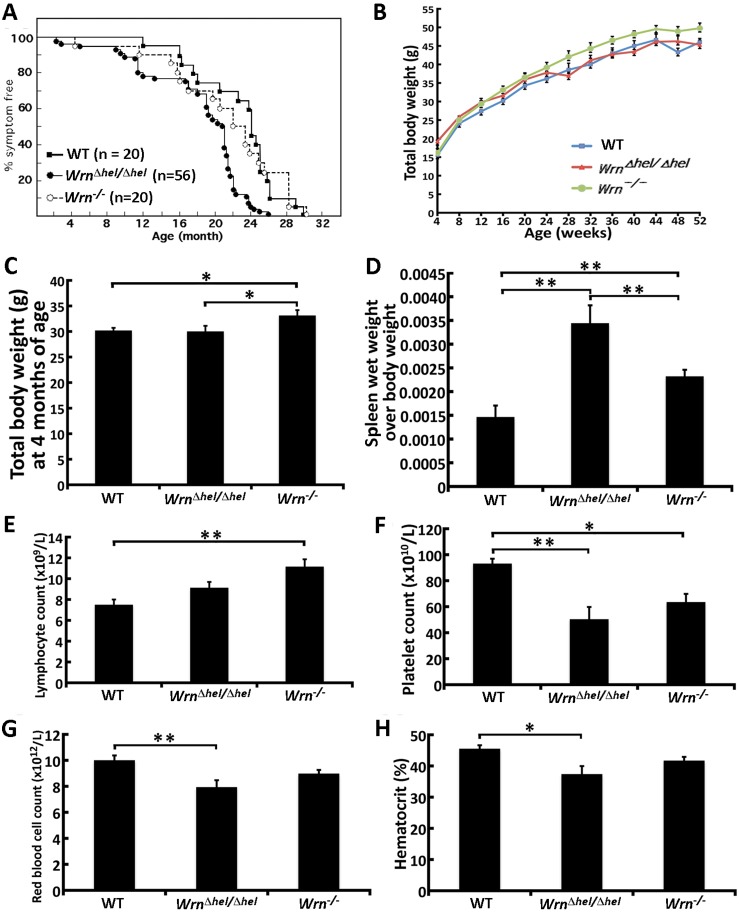
Phenotypic traits of Wrn
Δhel/Δhel and Wrn
-/- mice.(A) Percentage of disease-free animals with age. The number of animals in each group is indicated (50% males + 50% females). (Log rank tests: WT vs. Wrn
Δhel/Δhel mice, P = 6.8x10-5; WT vs. Wrn
-/- mice, P = 0.001; Wrn
Δhel/Δhel
vs. Wrn
-/- mice, P = 0.955). (B) Measures of males total body weight from the age of 4 to 52 weeks (n = 6–19 males). (C) Total body weight at four months of age (n = 6–10 males). (D) Ratio of spleen wet weight over total body weight at four months of age (n = 6 males). (E) Lymphocyte blood count at four months of age (n = 5 males). (F) Platelet blood count at four months of age (n = 5 males). (G) Red blood cell count at four months of age (n = 5 males). (H) % hematocrit at four months of age (n = 5 males). Bars in all the graphs represent SEM.